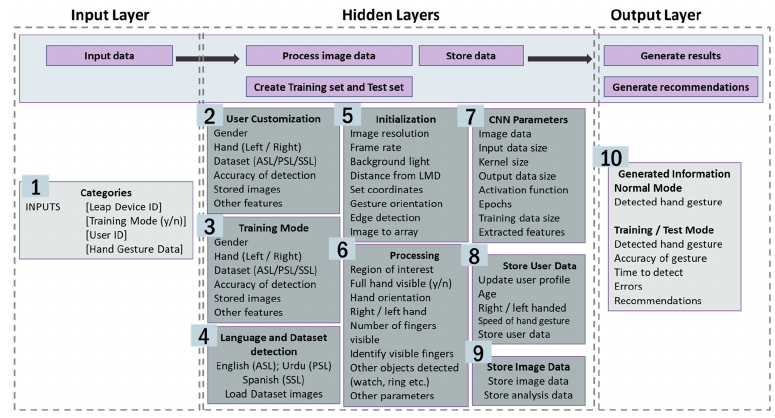
Figure 5. Machine learning algorithm.